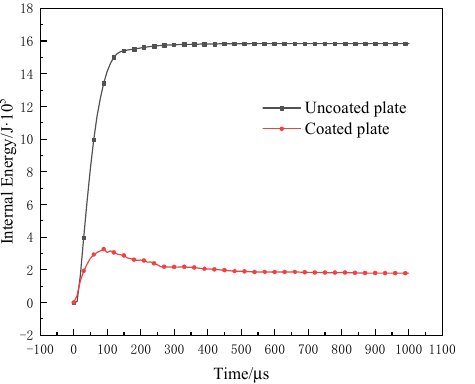
Figure 21. Internal energy curves of coated and uncoated reinforced concrete